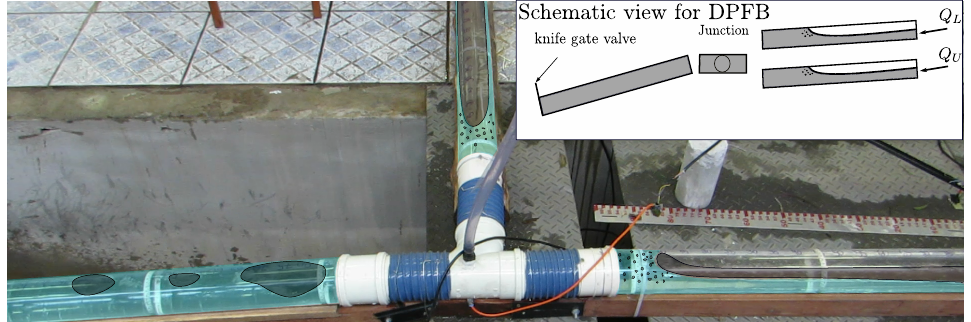
Figure 7. Visualization at some seconds after the knife gate closure showing the pressurization process for DPFB.